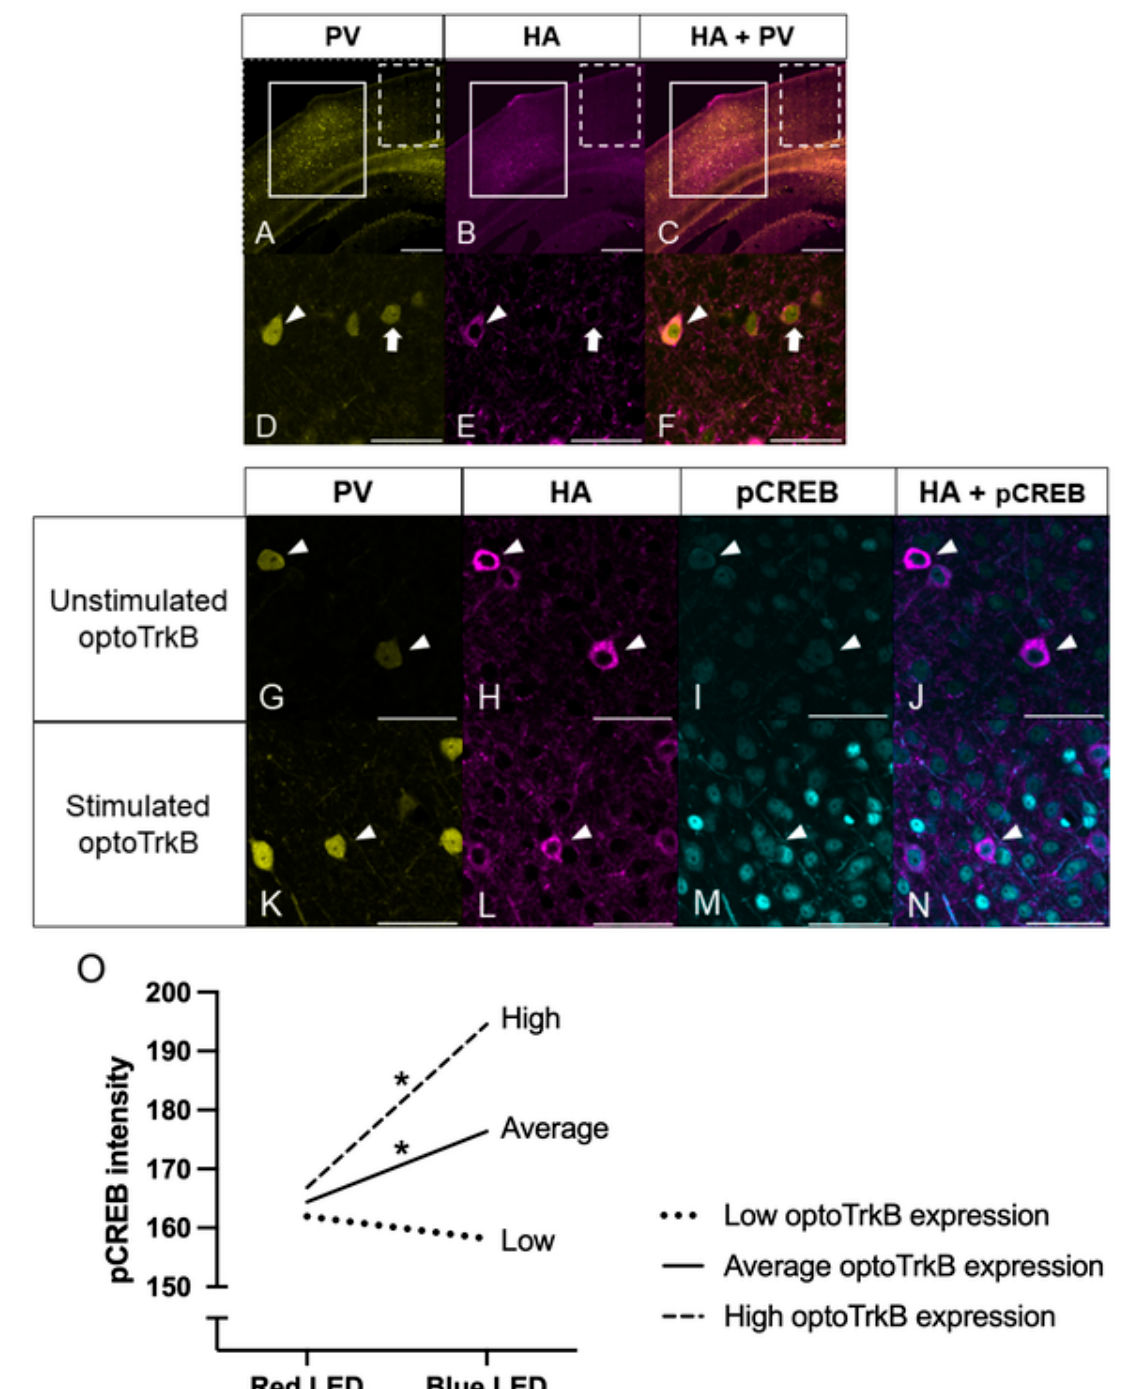
Figure 2. ( A – F ) OptoTrkB (E281A) was successfully expressed and activated in PV + interneurons in the visual cortex of PV-Cre mice. Representative images of V1 stained with anti-PV antibody ( A , D ), HA antibody ( B , E ), and merged ( C , F ). HA-expressing neurons also express PV, indicating that optoTrkB (E281A) is specifically expressed in PV + interneurons. Solid outline, dashed outline, arrow- heads, and arrows indicate the infected area, non-infected area, PV + interneurons infected with opto- TrkB (E281A), and PV + interneurons not infected with optoTrkB (E281A), respectively. ( G – N ) Light- stimulated PV + interneurons show higher pCREB intensity than unstimulated PV + interneurons. Representative images of V1 staining with antibodies of anti-PV ( G , K ), HA ( H , L ), pCREB ( I , M ), and merged HA and pCREB ( J , N ). Neurons in unstimulated ( G – J ), and stimulated brain ( K – N ). Scale bar ( A – C ): 500 um; scale bar ( D – N ): 50 um. Arrowheads point to PV + interneurons infected with